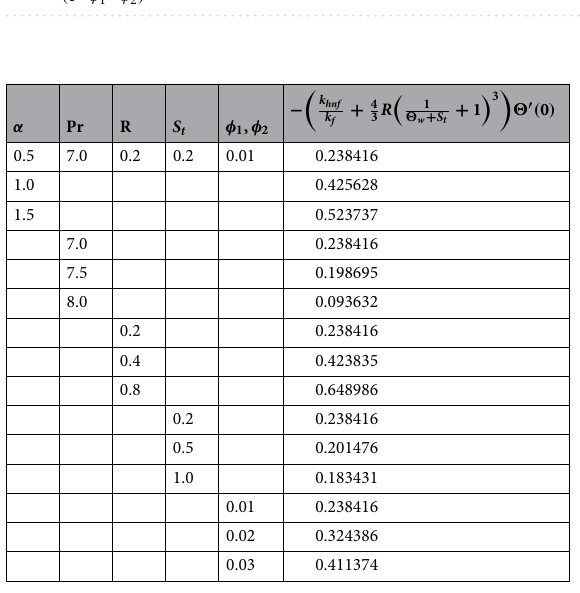
Table 3. Different physical variables have an impact on the Nusselt number 1